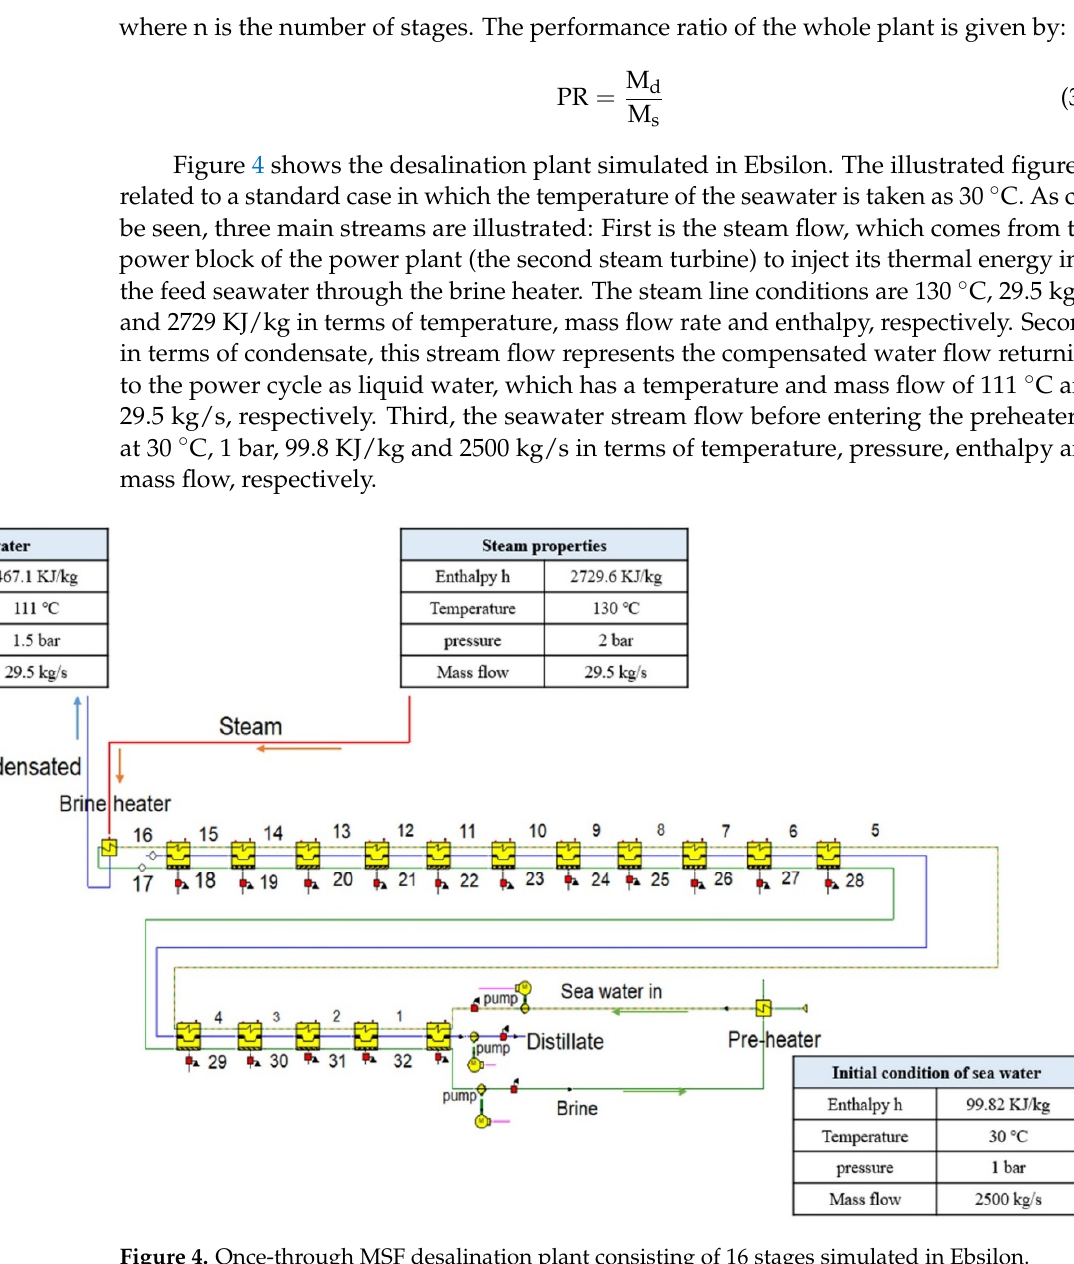
Figure 4. Once-through MSF desalination plant consisting of 16 stages simulated in